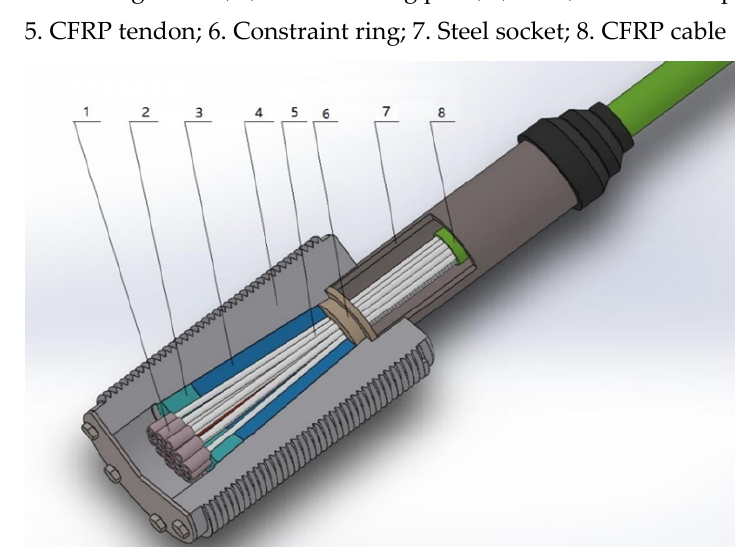
Figure 1. Composite anchorage device.